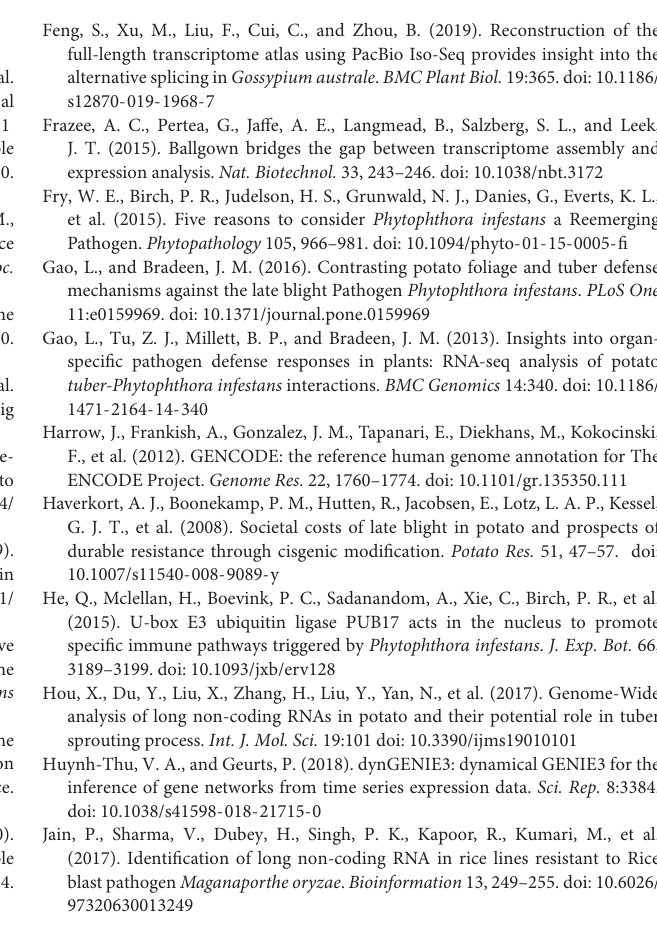
Supplementary Table 13 | Constructing GRN using lncRNAs and other mRNAs by performing GENIE3. Supplementary Table 14 | The primers of this work are